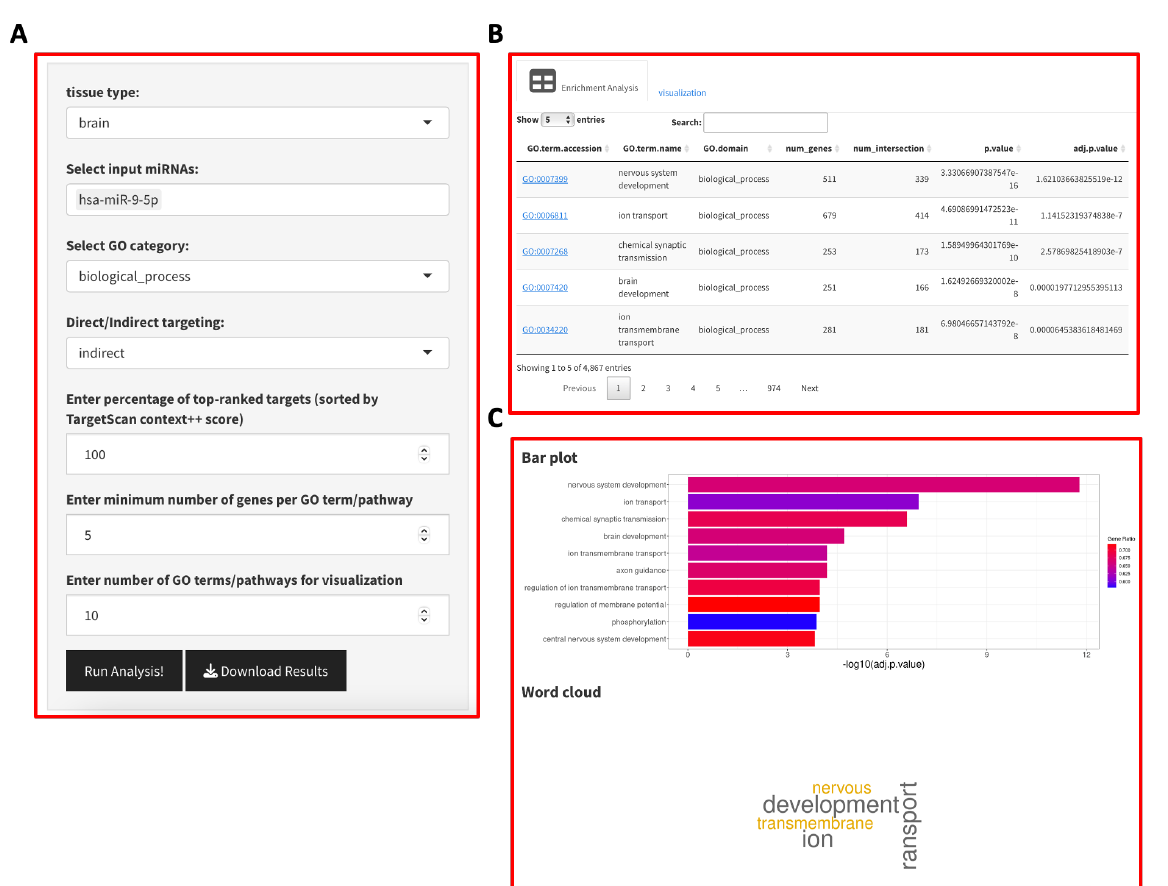
Figure 6. User interface of miRinGO R shiny application. ( A ) input parameters; ( B ) Table with miRNA GO enrichment analysis; ( C ) Bar plot and word cloud summarizing the top enriched GO terms.